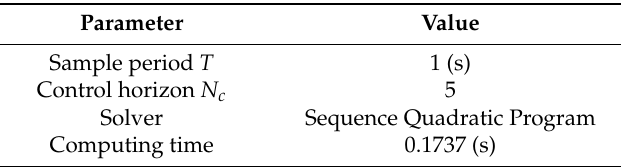
Table 5. Computing time of MPC